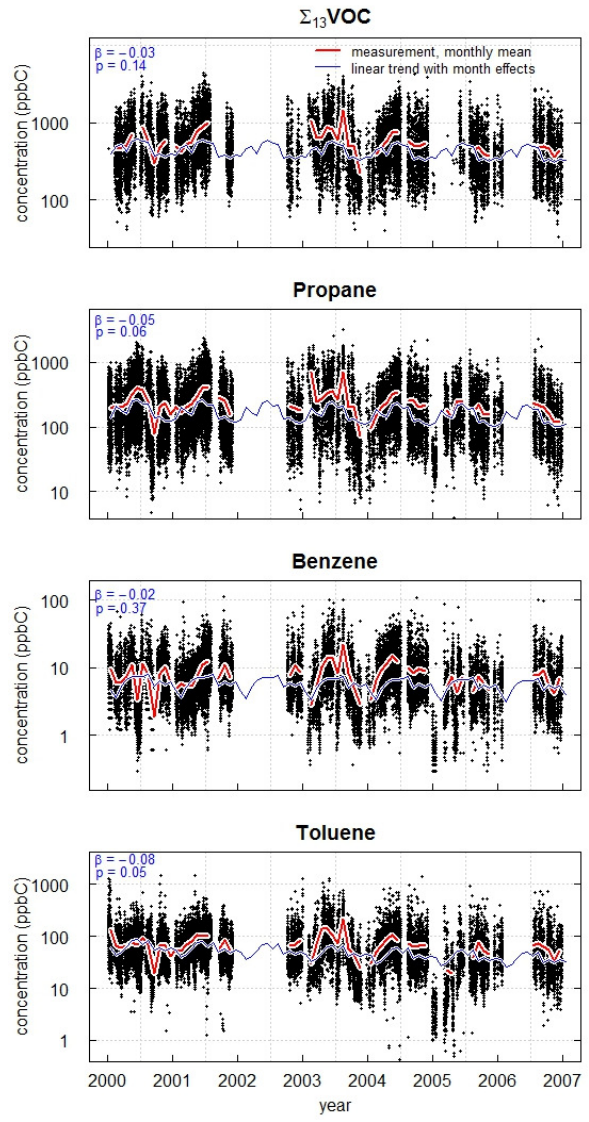
Fig. 2. Time series, monthly means and linear trend with month effects of Σ 13 VOC, propane, benzene and toluene from 2000 to 2007.